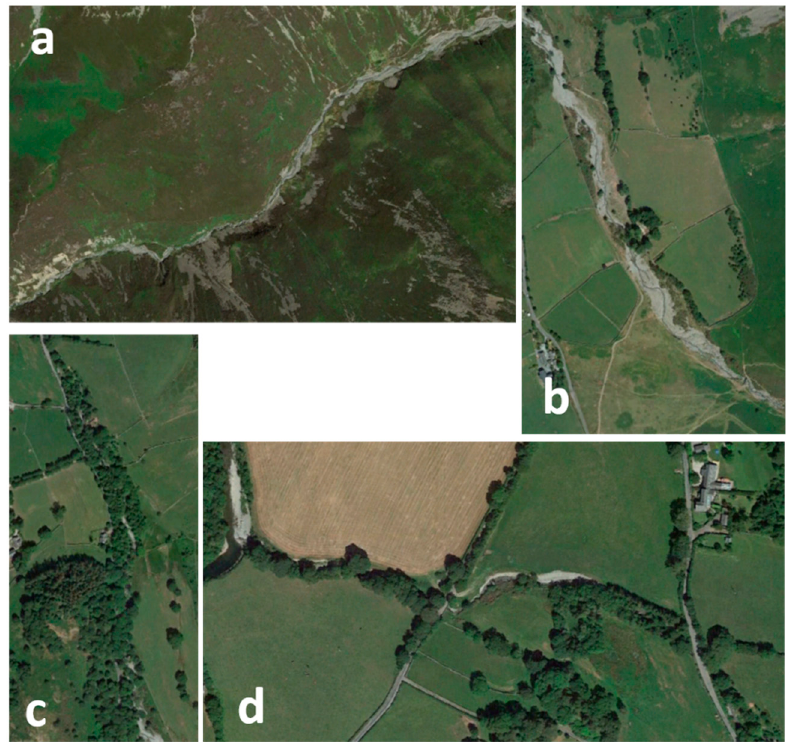
Figure 2. Changing character of Liza Beck, ( a ) bedrock / boulder cascade, ( b ) boulder dominated torrent, ( c ) single-thread / bifurcated, ( d ) historically straightened single-thread.